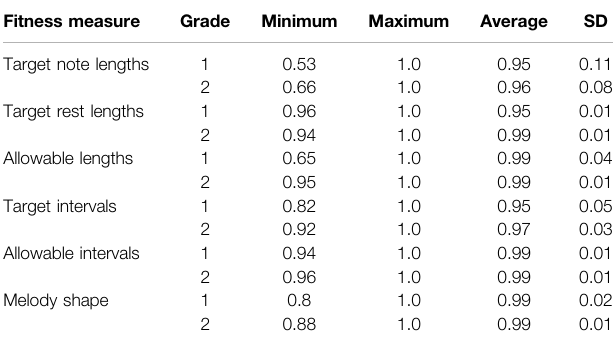
TABLE 8 | Summary of fi tness values for each grade level of generated exercises. Shows that at least one exercise reached the maximum value for each fi tness measure (i.e.,1.0),and thattheaverage fi tnessvaluesforeachmeasurewerehigh at every dif fi culty